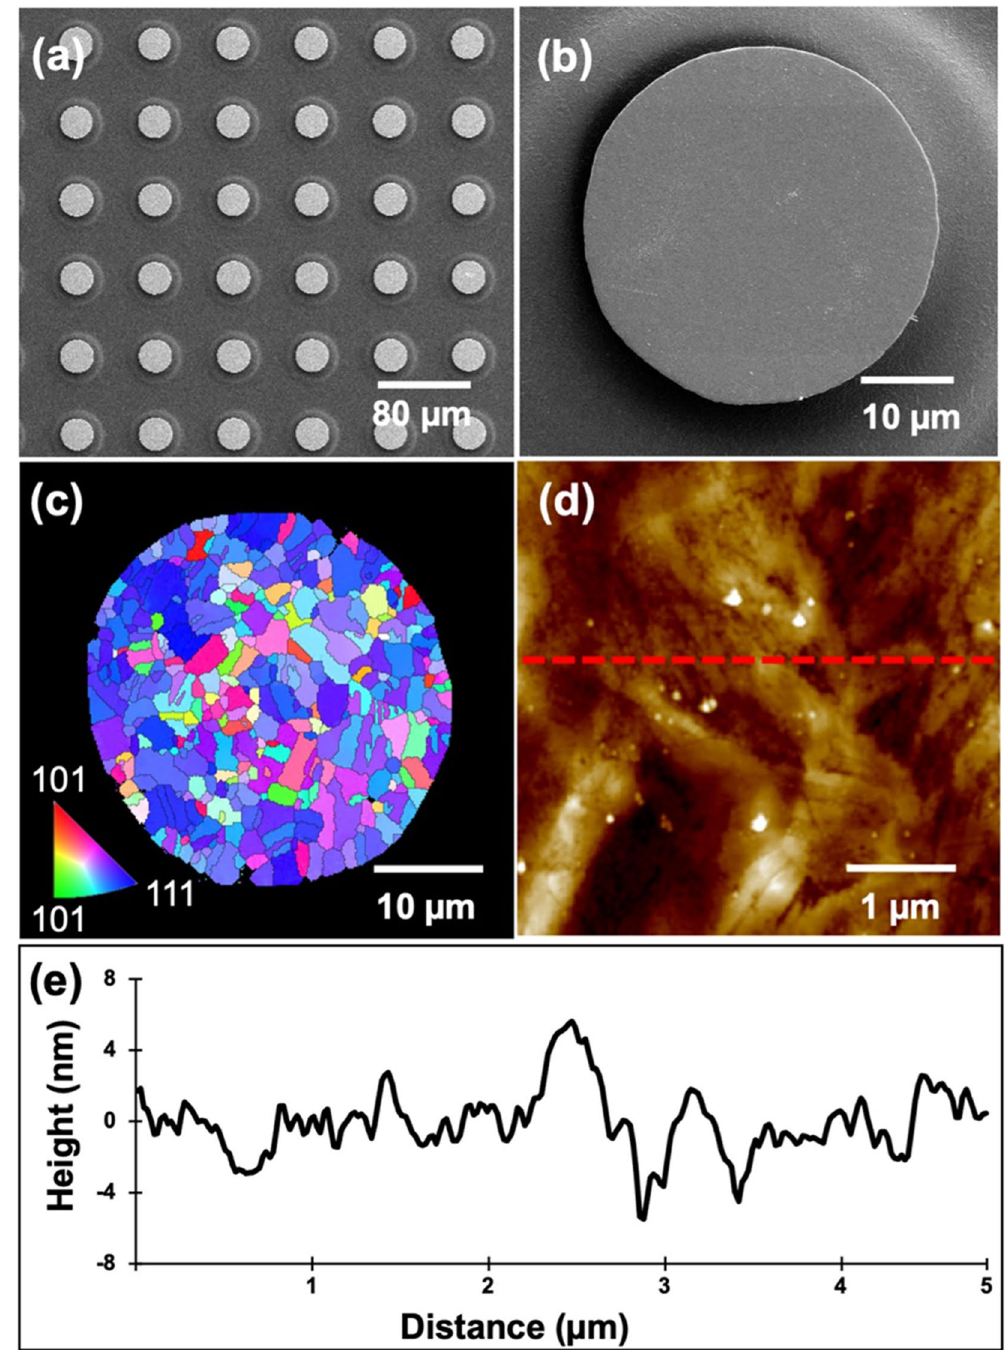
Figure 2. Top-view SEM micrograph of the ( a ) nt-Cu bump array with an enlarged image of a ( b ) single microbump flatted by CMP. ( c ) EBSD image at the normal direction (ND) of the bonding surface showing ~ 50% 〈 111 〉 orientation. ( d ) AFM micrograph taken in an area of 5 × 5 μm. The root mean square roughness ( R the bumps was ~ 4 nm. ( e ) Typical surface geometry of the microbumps scanned from the red dotted line in ( d